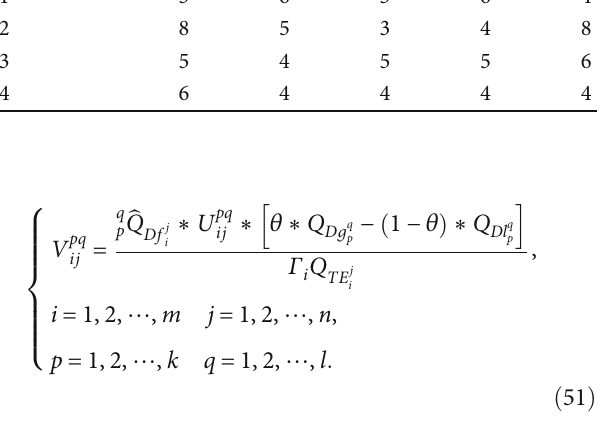
Table 10: Design task-average task amount. Task